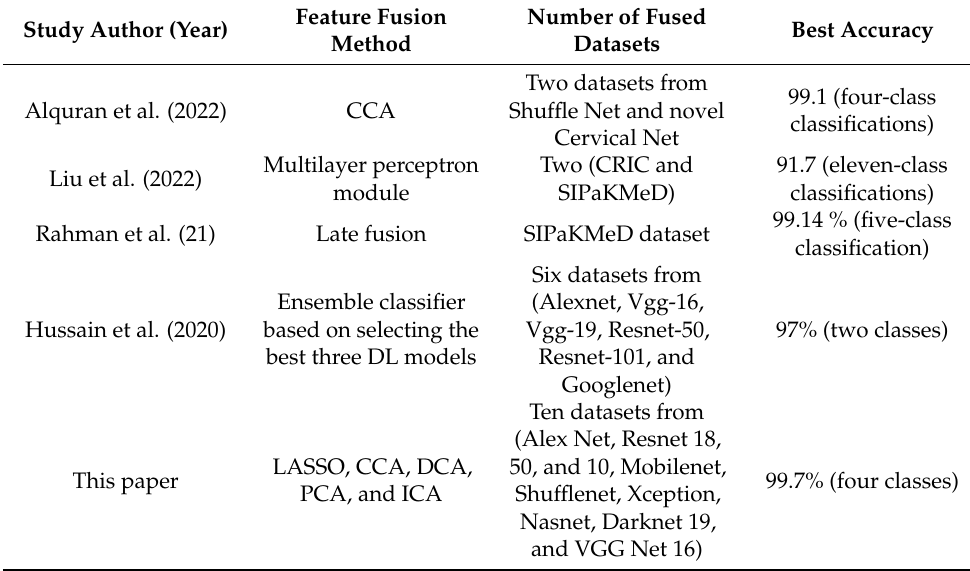
Table 3. Comparison with literature study used on cervical cancer images. The mentioned study focuses on using a fusion technique for the cervical cancer classification problem.